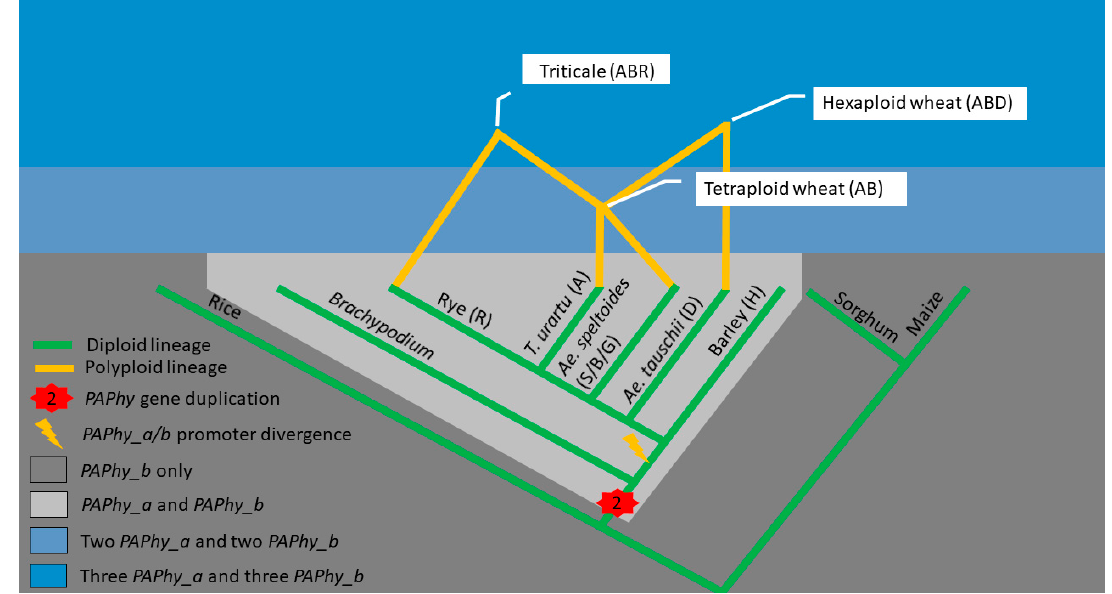
Figure 1. Key events in PAPhy evolution. Gene duplication and divergence of the PAPhy_a/b promoters and further duplications through polyploidization. For simplicity, rye is assumed to have just one PAPhy_a locus, and phylogenetic distance is not drawn to scale.